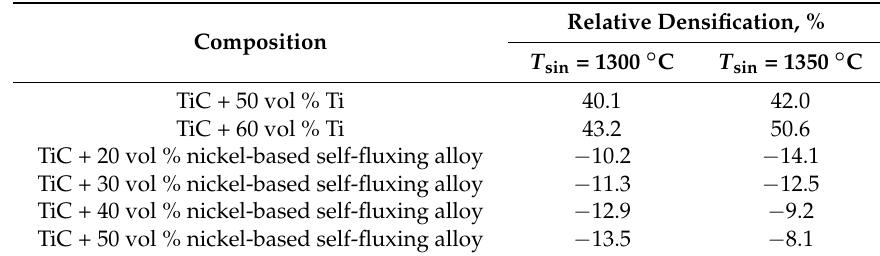
Table 2. Relative densification of the SHS compacts with various volume content of metal binder sintered at 1350 °C.